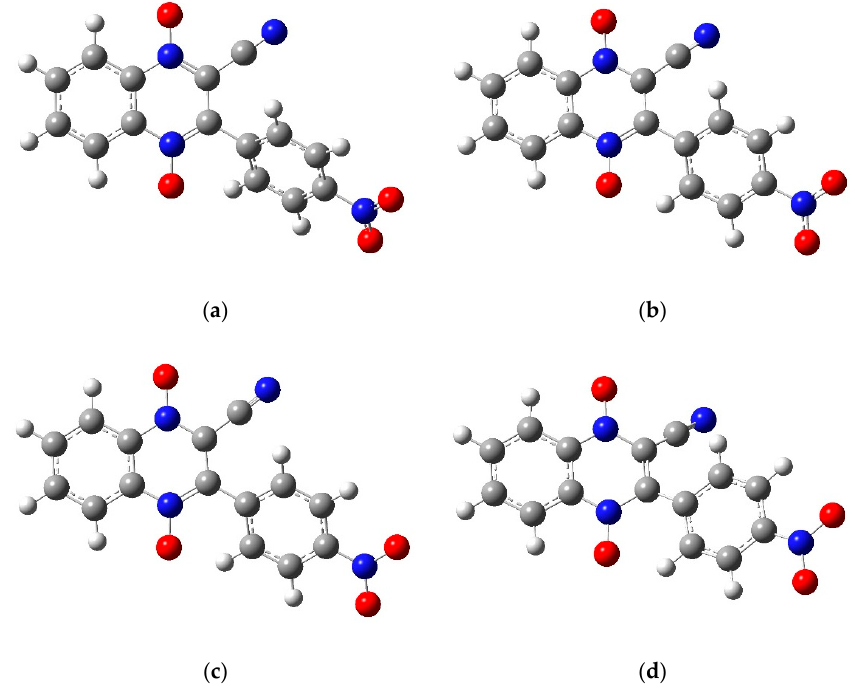
Figure 8. The optimized structures for molecule 1e using the 6-31g basis set: ( a ) the neutral molecule, ( b ) the anion product of wave 1 with the radical on the carbon attached to the cyano group, ( c ) the dianion product of the NO wave with radicals on the carbon attached to the cyano and on nitro group, and ( d ) the trianion product of wave 2. Figures created in GaussView 5 [39] and optimized in Gaussian 09 [38].